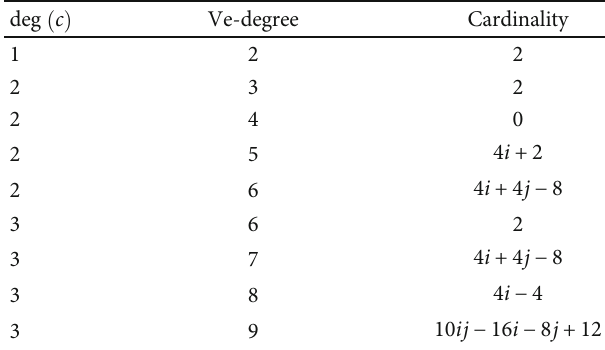
- II ½ i , j (cid:2) . 4